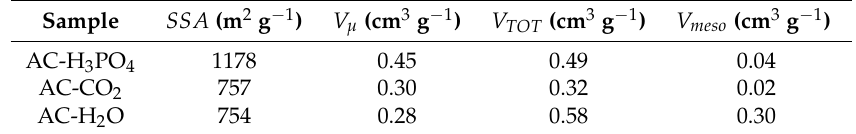
Table 1. Textural properties of carbon materials. SSA , specific surface area; AC, activated carbon.